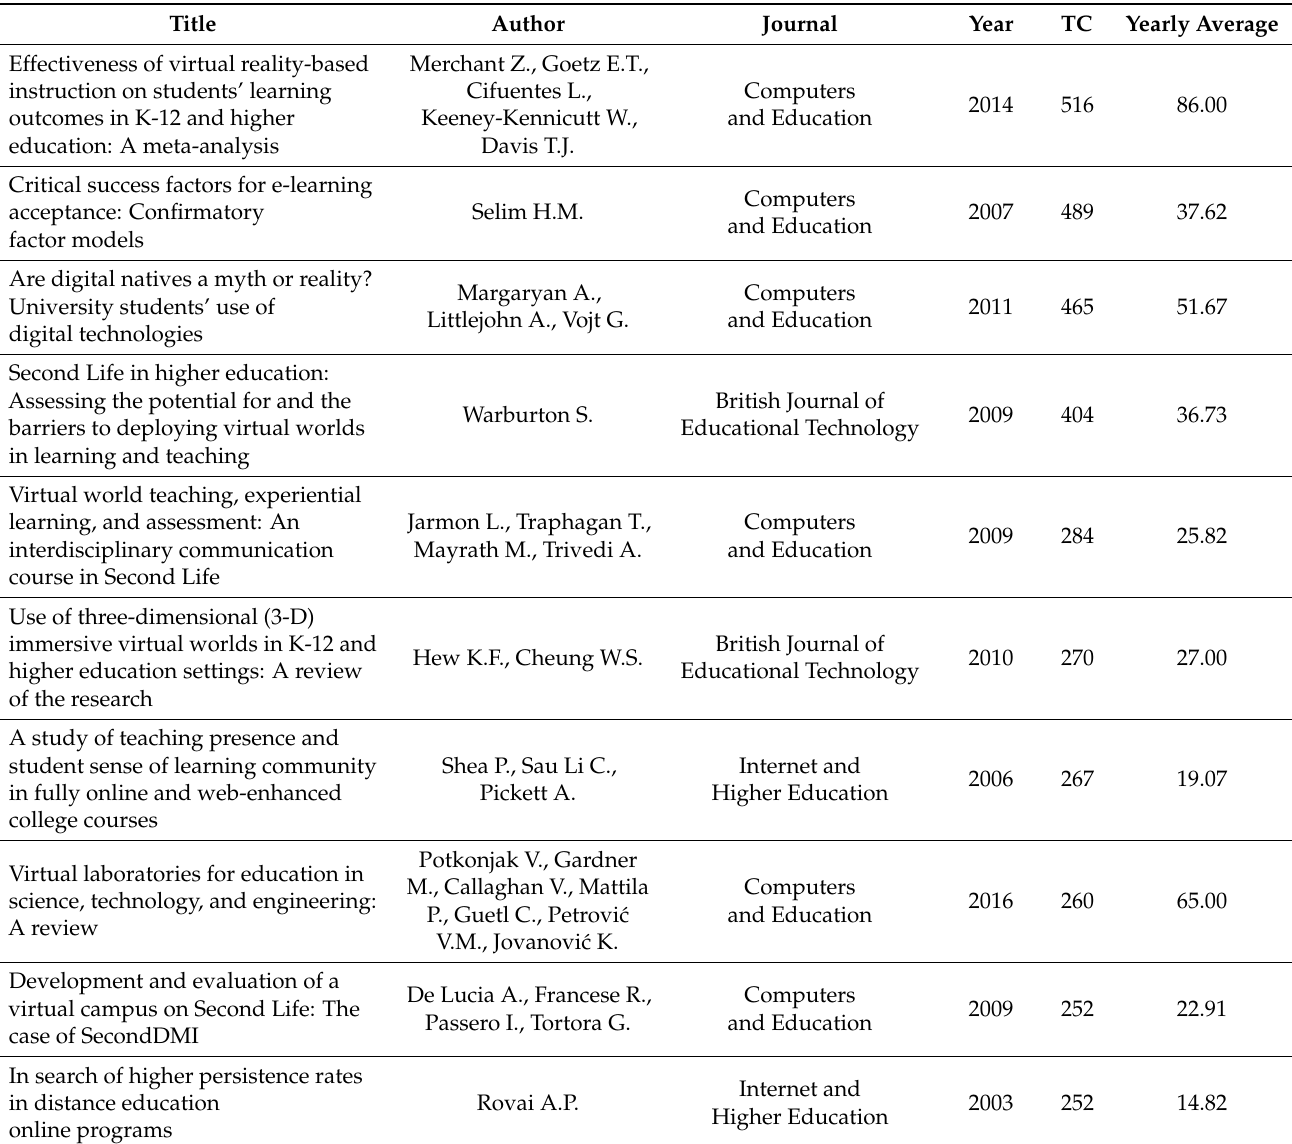
Table 4. Most trending and cited publications on